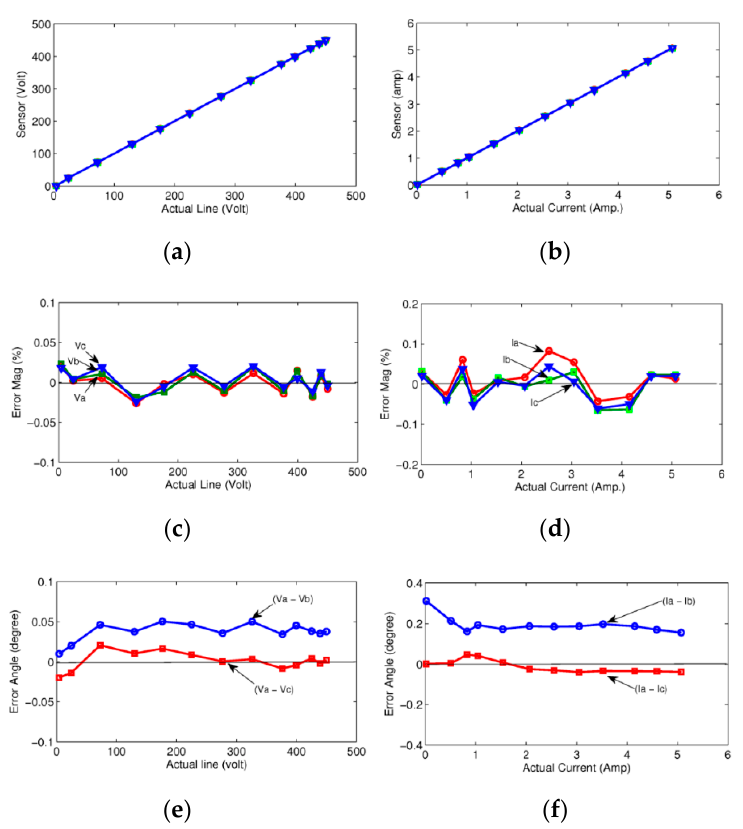
Figure 7. The measured and processed calibration characteristics: the calibrated values of voltage ( a ) and current ( b ), the residual magnitude errors in three voltage ( c ) and current sensors ( d ) and the relative angle errors for the three voltage ( e ) and current sensors ( f ).